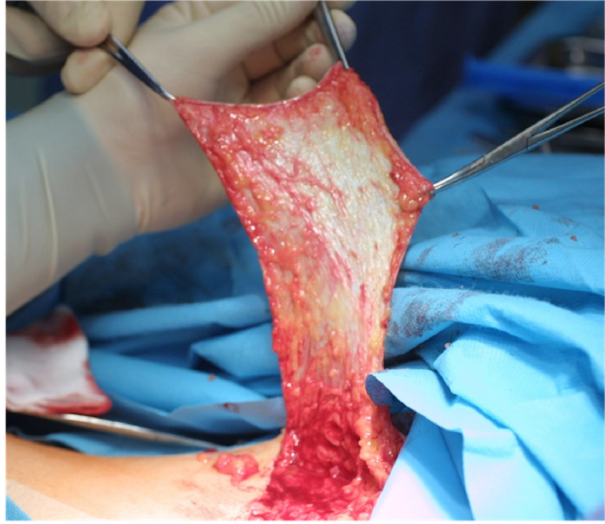
Figure 1. Free full-thickness skin graft harvesting from the groin area.